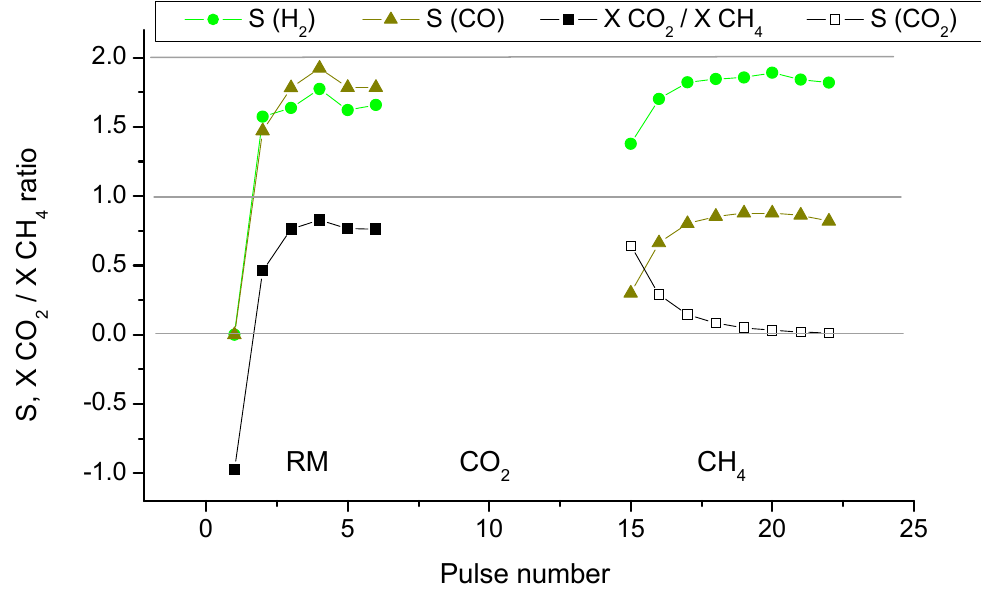
Figure 8. Product selectivities and conversions ratio in a series of pulses at 773